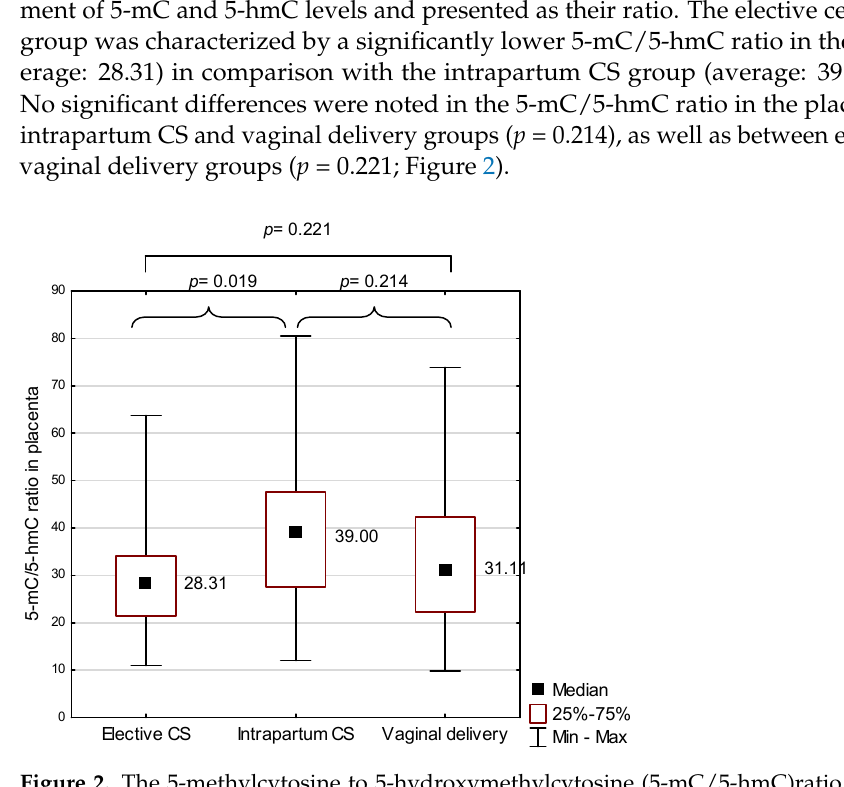
44.45) than female newborns (average: 27.57) in the intrapartum cesarean section group ( p = 0.028). Gender differences were not observed in the elective cesarean section or